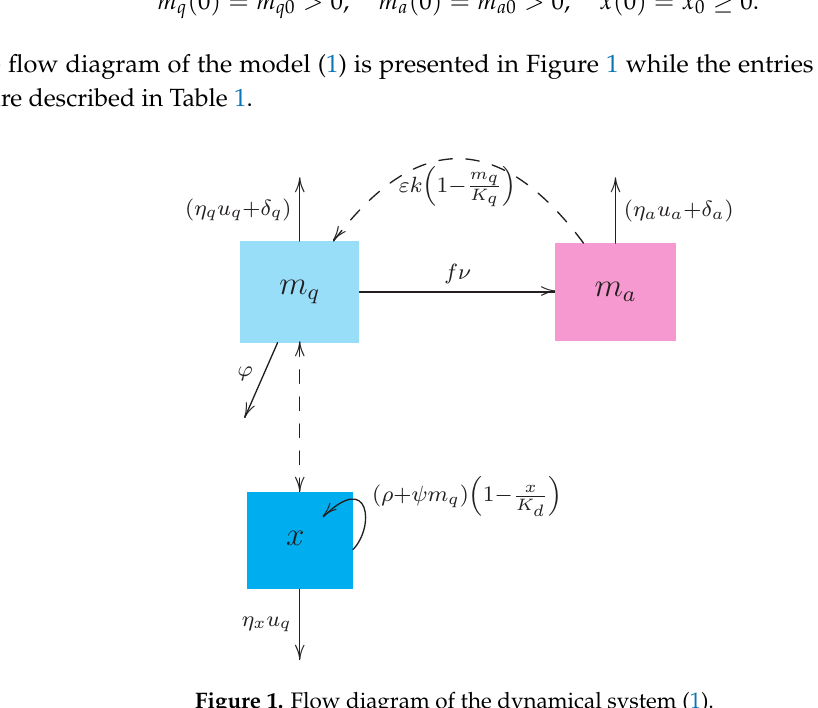
Figure 1. Flow diagram of the dynamical system (1). Table 1. Entries of the controlled model